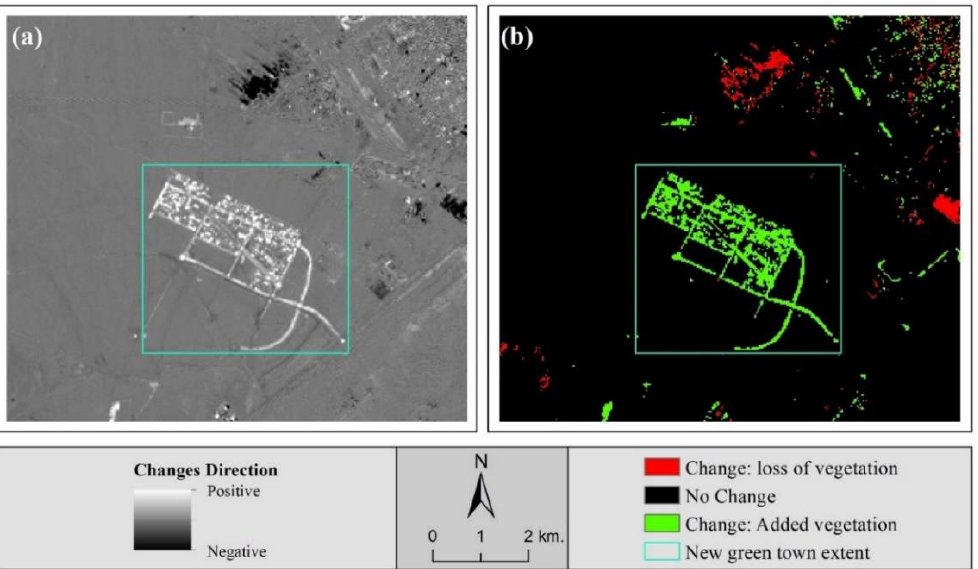
Figure 7. The difference in normalized difference vegetation index (NDVI) values in the study area between 2022 and 2013 in two representations of continuous values ( a ) and discrete classes ( b ).